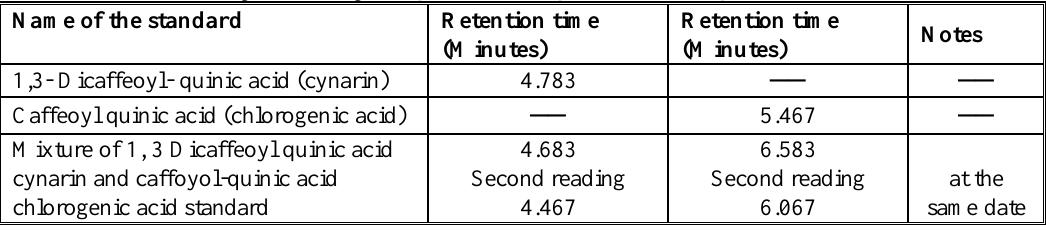
Table 3: Standard of Cynaria scolymus phenolic compounds after separation in HPLC. Name of the standard